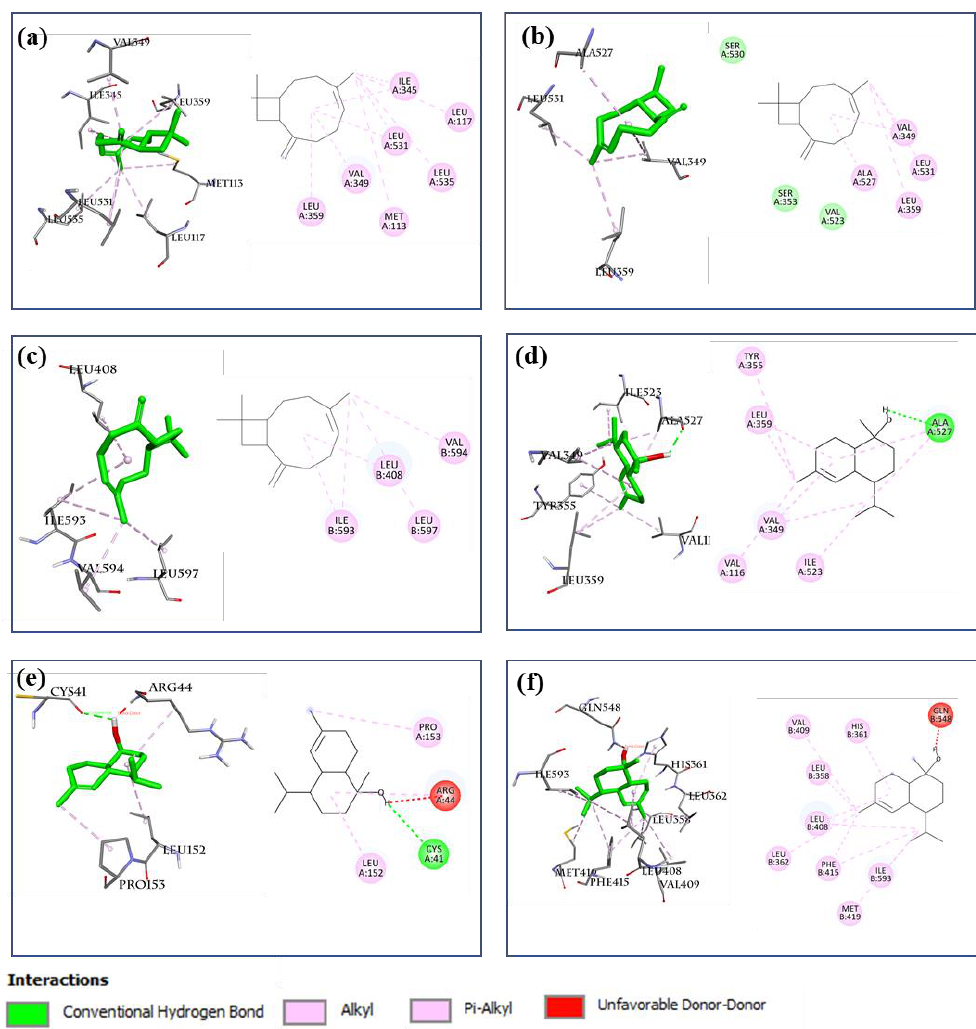
Figure 10. Docking analysis of compounds 16 and 27 with COX-1, COX-2, and ALOX15. Interaction analysis of compound 16 (left: 3D, right: 2D) with ( a ) COX-1 (PDB ID: 4O1Z), ( b ) COX-2 (PDB ID: 6COX), and ( c ) ALOX15 (PDB ID: 2P0M). Interaction analysis of compound 27 (left: 3D, right: 2D) with ( d ) COX-1(PDB ID: 4O1Z), ( e ) COX-2(PDB ID: 6COX), and ( f ) ALOX15 (PDB ID: